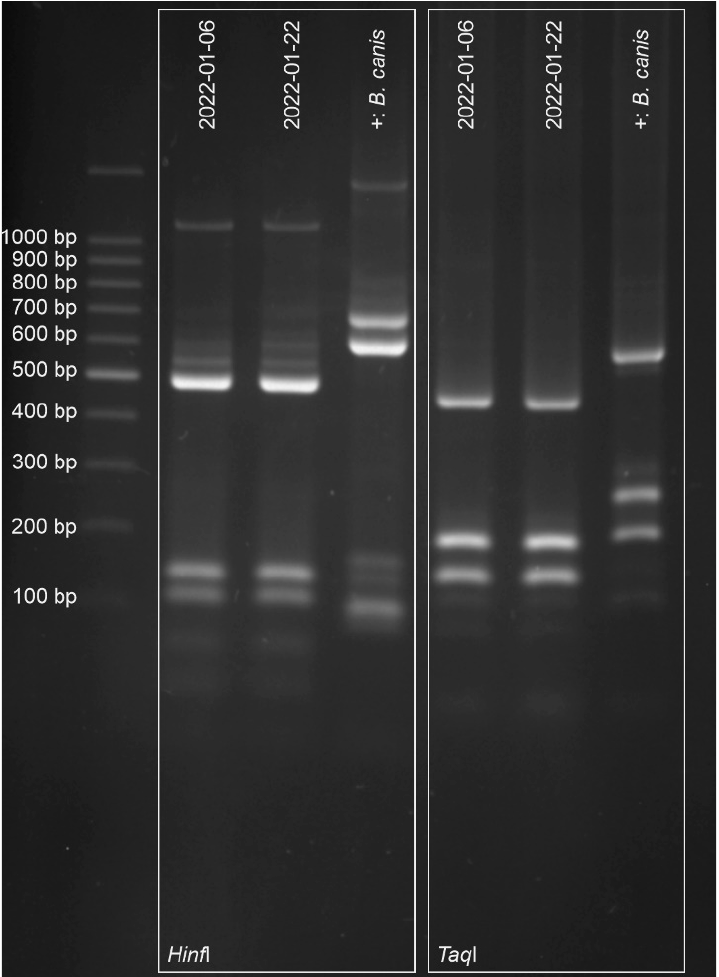
Figure 3. Gel electrophoresis of PCR-RFLP 18S rRNA gene fragments. Lane 1 presents a 100 bp molecular weight marker, lanes 2 to 4 and lanes 5 to 7 present PCR-RFLP products digested with endonucleases HinfI and TaqI, respectively. Lanes 2, 3, 5, and 6 present samples of the patient from two different time points, and lanes 4 and 7 present a sample with B. canis as positive controls.